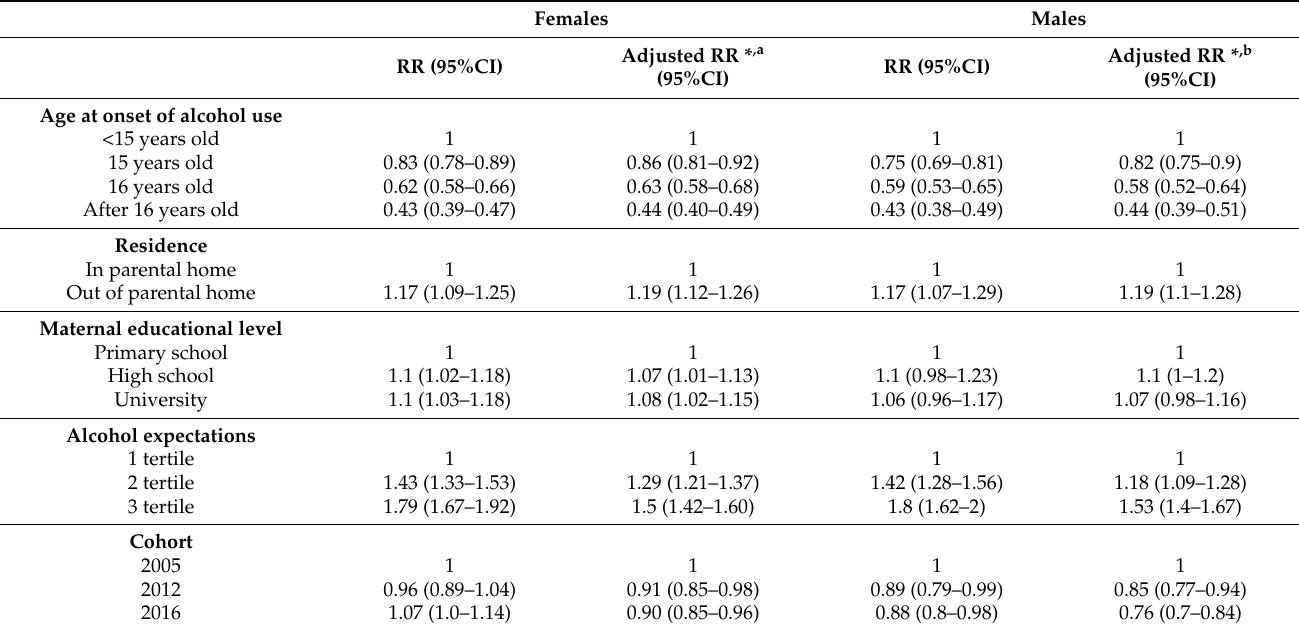
Table 2. Influence of explanatory factors on global AUDIT test score by gender. Negative binomial regression.